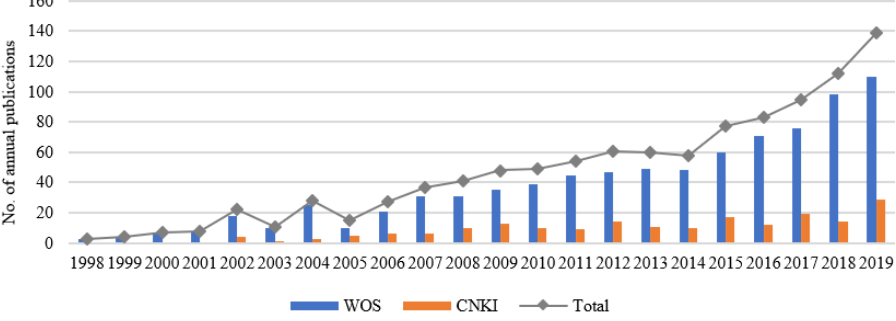
Figure 1. Number of annual publications on urban growth boundary studies from 1998 to 2019.